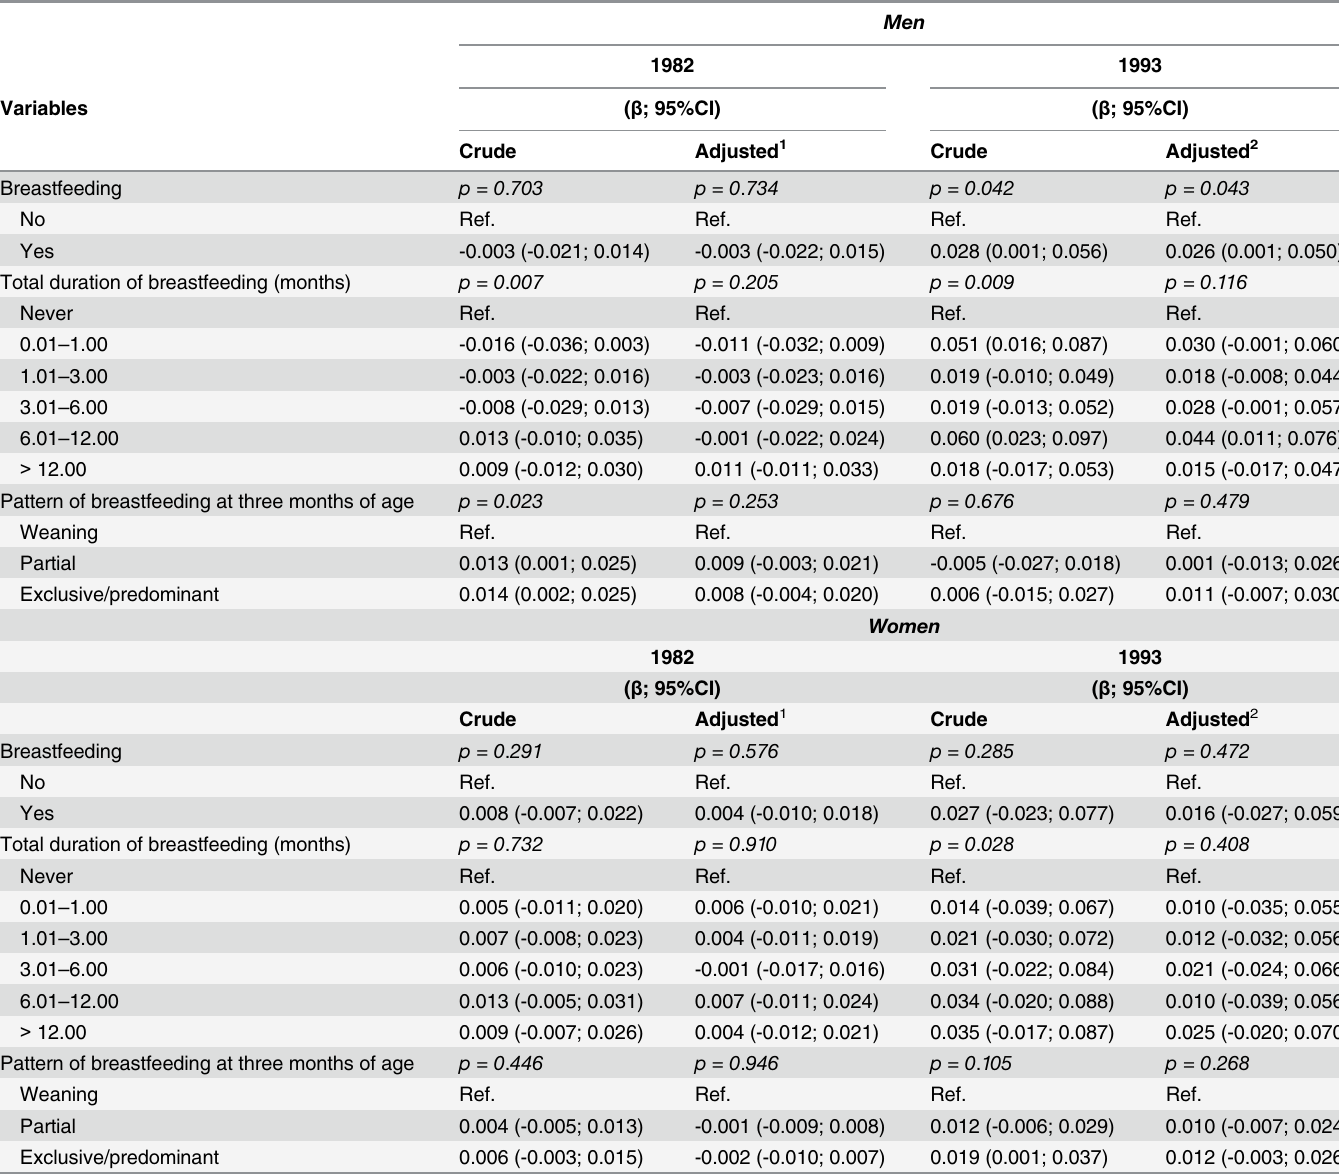
Table 4. Crude and adjusted coefficients of the association between breastfeeding variables and whole body bone mineral density (BMD) at 18 and 30 years for men and women. The 1982 and 1993 Pelotas Birth Cohorts.